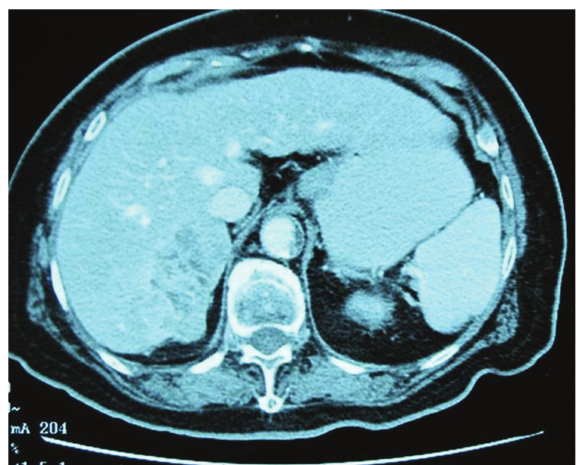
Figure 1: CT scan showing heterogeneous vascular right adrenal mass, suggestive of a pheochromocytoma.